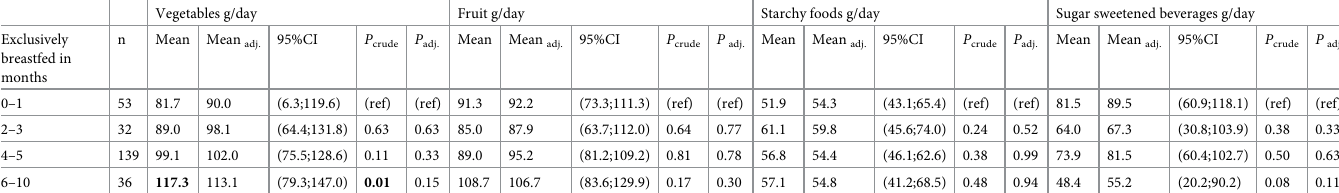
Table 3. Vegetables, fruit, starch and sugar sweetened beverages intake pr day in relation to exclusively breastfeeding duration. Vegetablesg/day